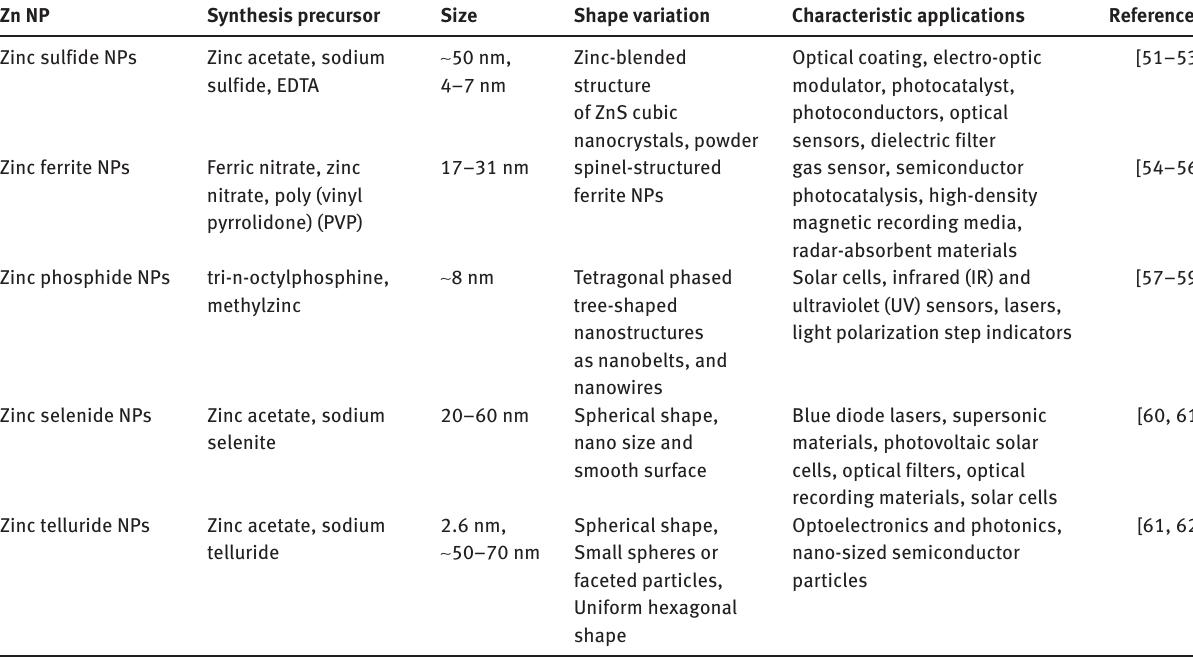
Table 2: Zinc NPs, synthesis, characteristics, and properties. Zn